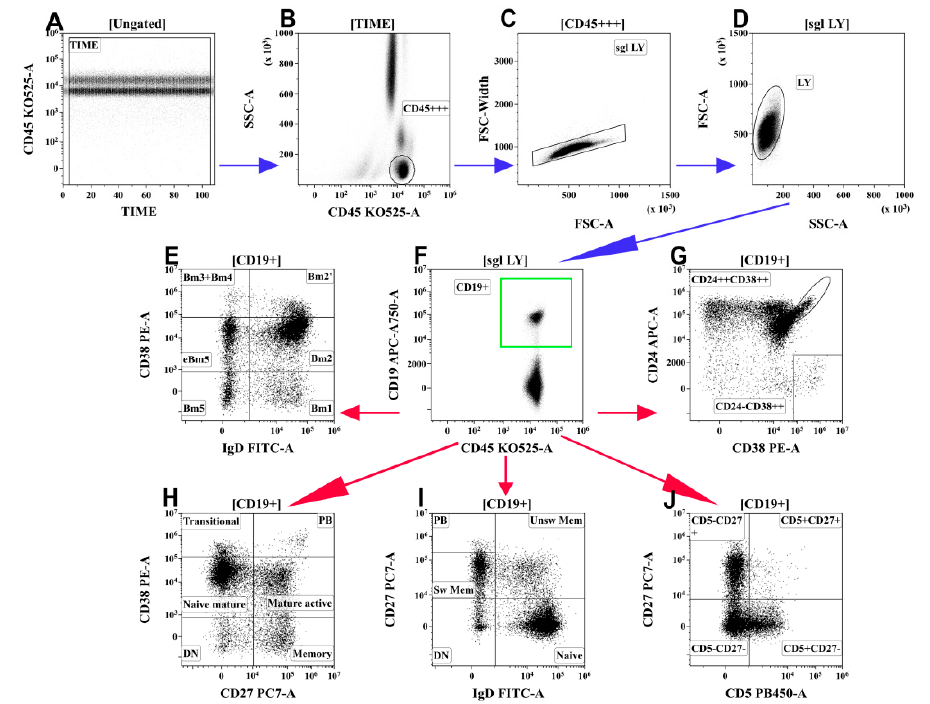
Figure 3. Gating and analysis strategy for B-cell immunophenotyping using flow cytometry. ( A ) Artifact exclusion included time gating. ( B ) Total lymphocyte subset purification based on side-scatter and bright CD45 expression. ( C ) Doublets exclusions from the analysis using FSC-area and FSC-width. ( D ) FSC; vs. SSC; gating to discriminate lymphocytes and cell debris. ( F ) B cells were gated as CD19+ lymphocytes. Next, distinct B cell subsets were identified using different patterns of co-expressing antigens ( E , G – J ). ( E ) Co-expression of IgD and CD38 (so-called “Bm1-Bm5” classification): six distinct B-cell subsets were identified, including “virgin naïve” Bm1 cells (IgD+CD38 − ), “activated naïve” Bm2 cells (IgD+CD38+), pre-germinal-centre Bm2 (cid:48) cells (IgD+CD38++), common subset, containing centroblasts and centrocytes (so-called “Bm3 + Bm4” cells, IgD–CD38++), and early memory (eBm5) and resting memory cells (Bm5)–IgD–CD38+ and IgD–CD38 − , respectively. ( G ) Co-expression of CD24 and CD38; transitional B cells were identified as CD24++CD38++ and circulating plasma cell precursors were identified as CD24-CD38++. ( H ) Co-expression of CD27 and CD38 allowed distinction of six B-cell subsets: CD27–CD38++ and CD27–CD38+ transitional and naive mature B cells, respectively; CD27–CD38 − ‘double-negative’ B cell; CD27+CD38+ activated mature cells; CD27+CD38 − resting memory cells; and circulating plasma cell precursors CD27++CD38++ (PB). ( I ) Co-expression of IgD and CD27 distinguished “naïve” B cells (IgD+CD27 − ) and three types of memory cells–“unswitched” memory cells (‘unsw mem’ IgD+CD27+), “class-switched” memory cells (sw mem IgD–CD27+), and so-called “double-negative” memory cells (DN IgD–CD27 − ), as well as circulating plasma cell precursors IgD–CD27++ (PB). ( J ) CD5 vs. CD27 co-expression allowed to identify the CD5+CD27 − B-cell subset, enriched with regulatory B and B1 cells. Blue arrows mean common steps of each gating strategy for B-cells, red arrows mean different strategies for gating analysis of